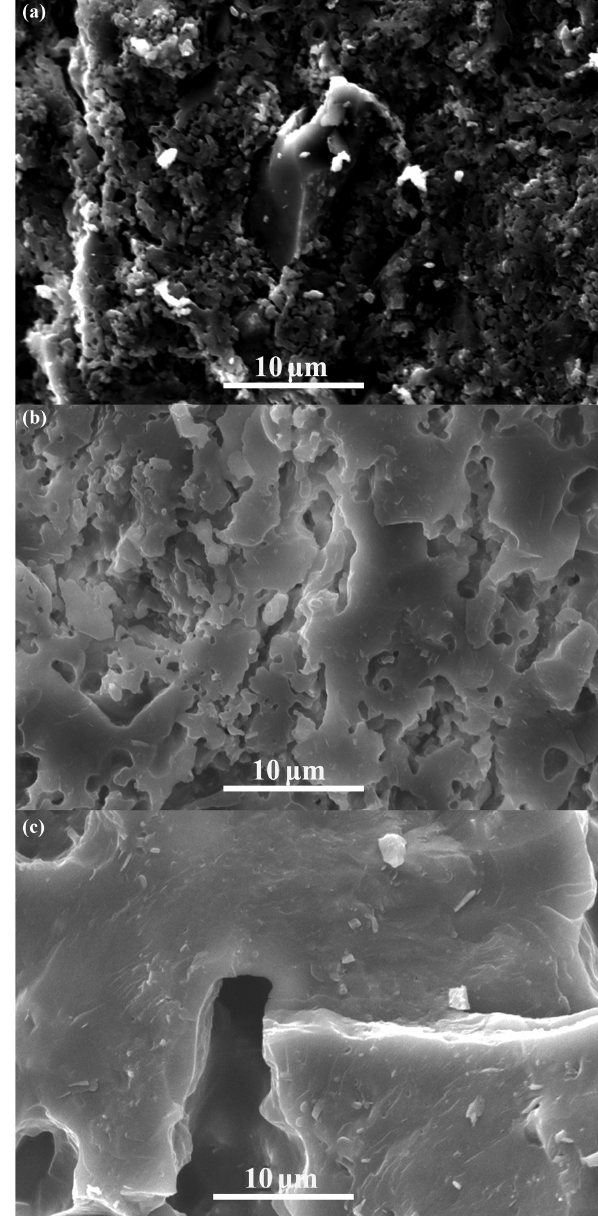
Figure 7: SEM microphotographs of the cordierite-based samples after sintering at 1,150°C (a), 1,200°C (b) and 1,400°C (c) for 2 h without